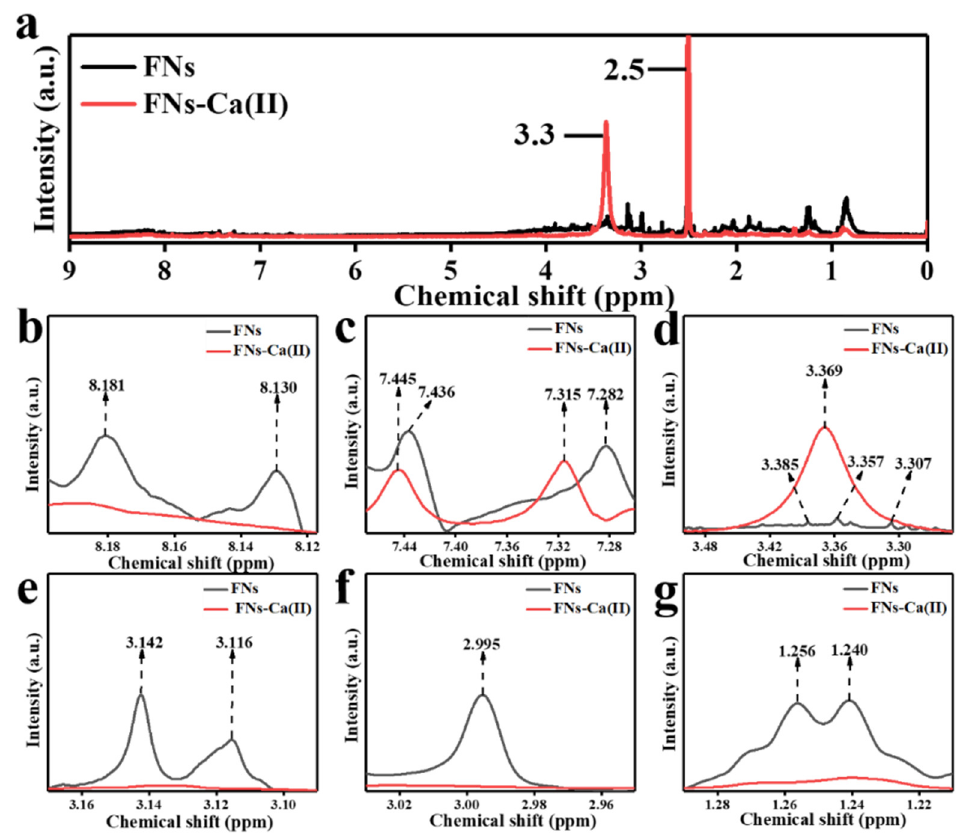
Figure 6. 1 H nuclear magnetic resonance (NMR) spectra of the FNs and FNs-Ca(II) ( a ), and enlarged 1 H NMR spectra ( b – g ) showing the specific NMR peaks of the FNs and FNs-Ca(II). 3.7. Cellular Bio-Distribution and Cytotoxicity of FNs and FNs − Ca(II)